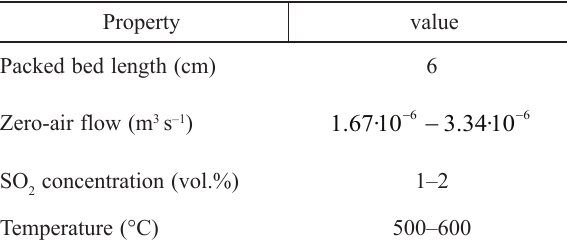
Table 2 – Operating conditions of the packed bed reactor Property value